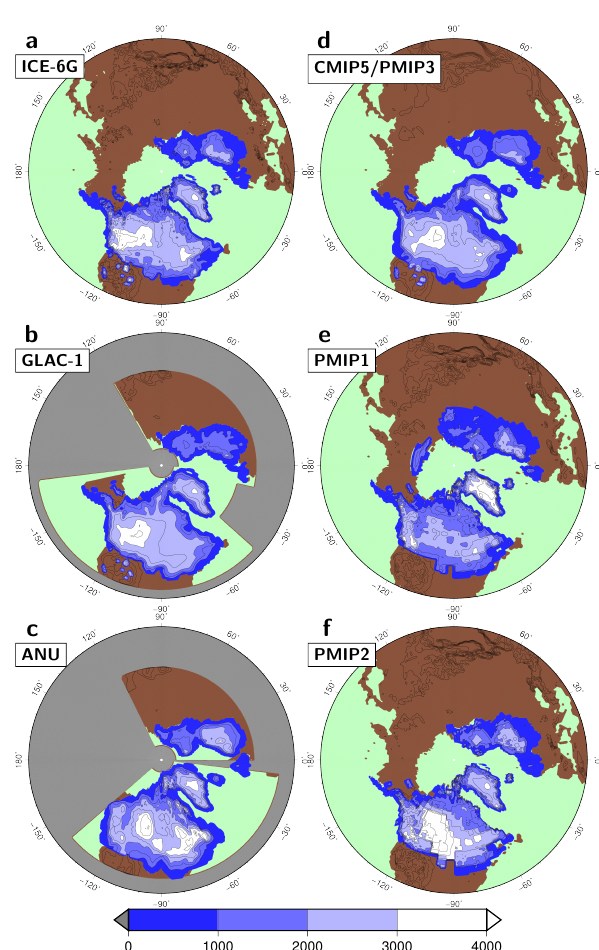
Figure 1. Surface elevation (m) at the Last Glacial Maximum (LGM) Northern Hemisphere ice sheets from the (a) ICE-6G v.2, (b) GLAC-1a and (c) ANU reconstructions, and for the (d) CMIP5/PMIP3 composite compared to the ice sheets used in (e) PMIP1 and (f)